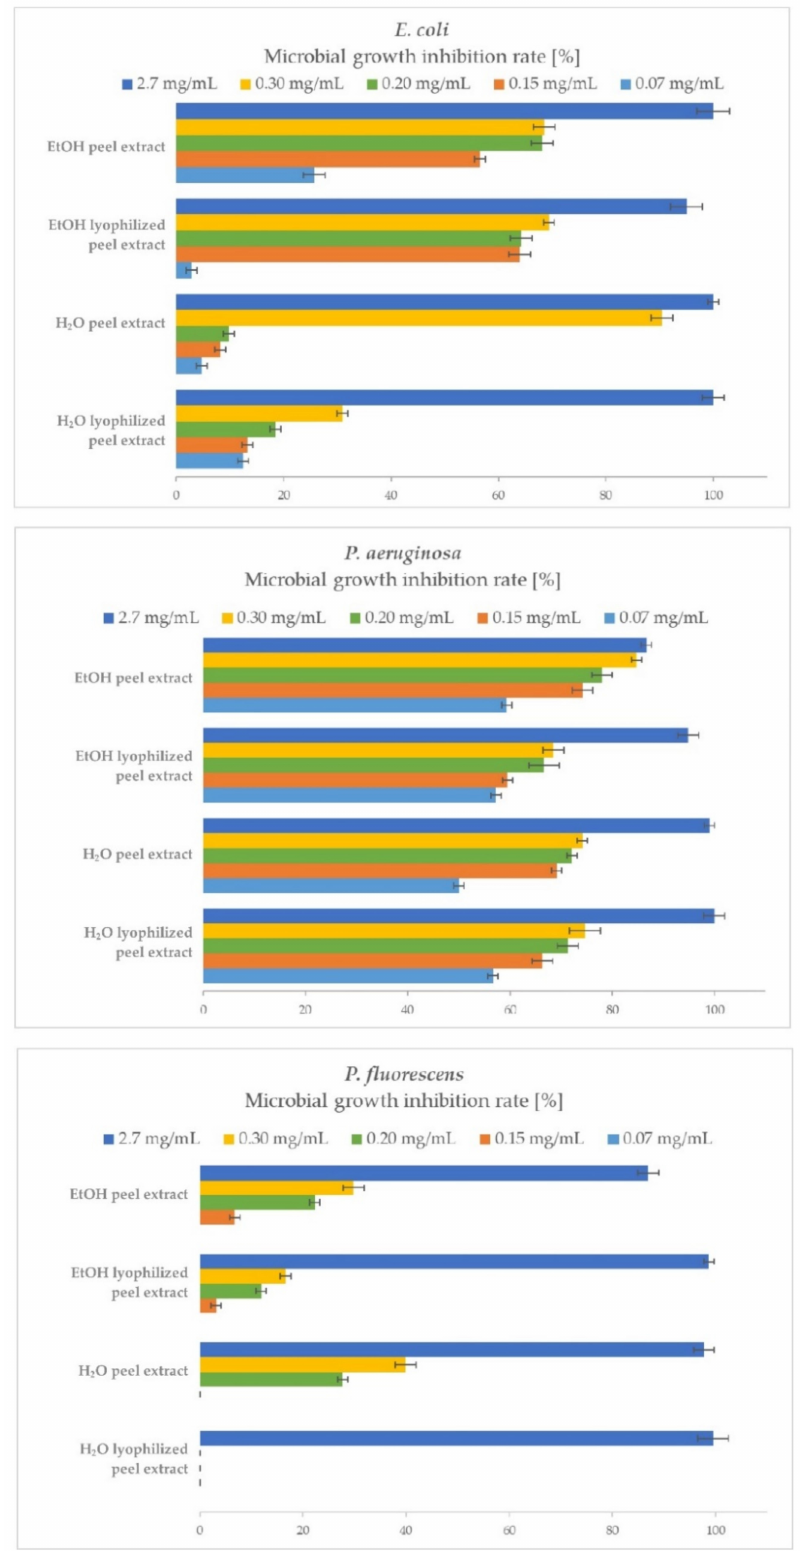
Figure 2. Microbial growth inhibition rates (MGIRs) for P. granatum extracts using 2.7, 0.3, 0.2, 0.15 and 0.07 mg of sample/mL of E. coli , P. aeruginosa , and P. fluorescens suspension. Initial concentrations of microorganisms were 1–5 × 10 6